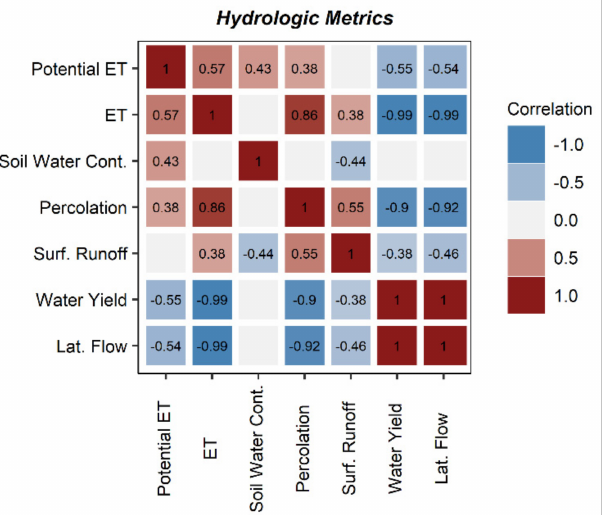
Figure 4. Correlations between the full list of modeled hydrologic metrics from the soil a water as- sessment tool (SWAT) ranging from − 1 (blue) to 1 (red). Non-significant correlations ( p -value > 0.05) were